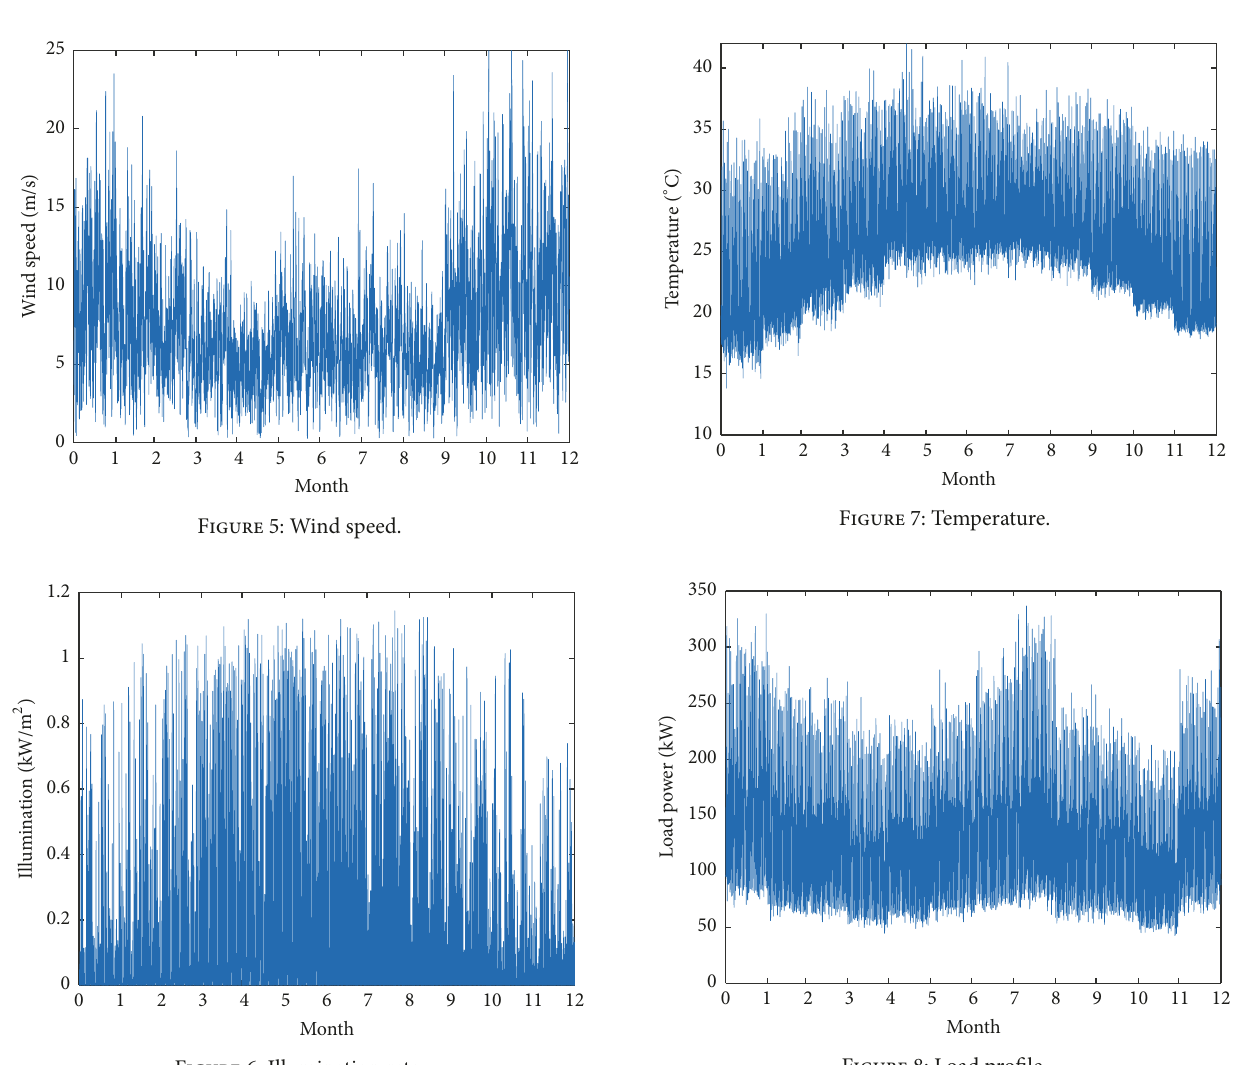
Figure 6: Illumination rate.